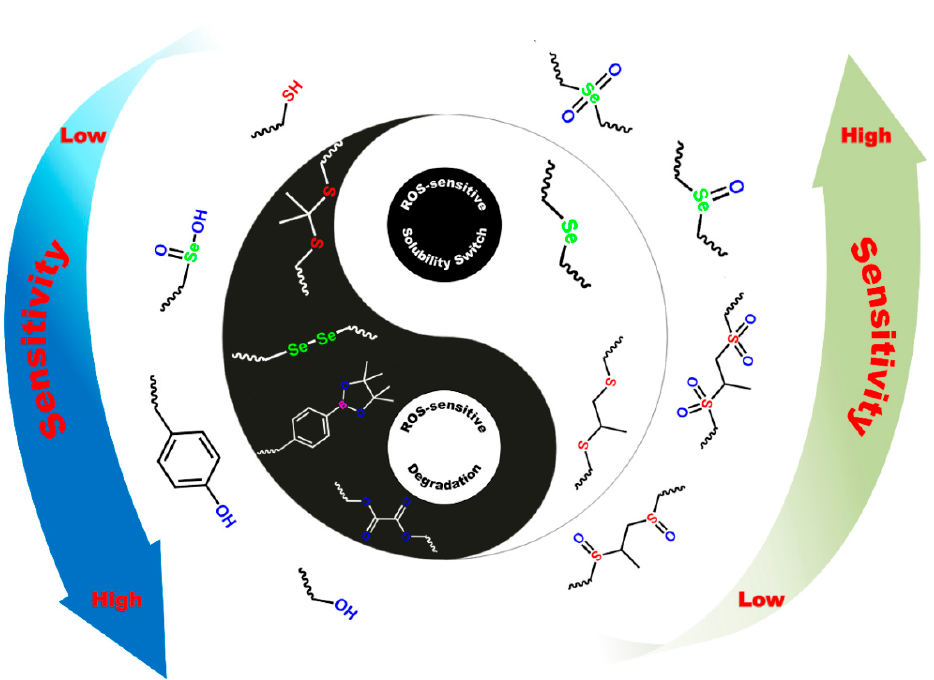
Figure 2. Two categories of ROS-responsive structure change and corresponding sensitivity of the polymeric biomaterials under oxidation stimulus.